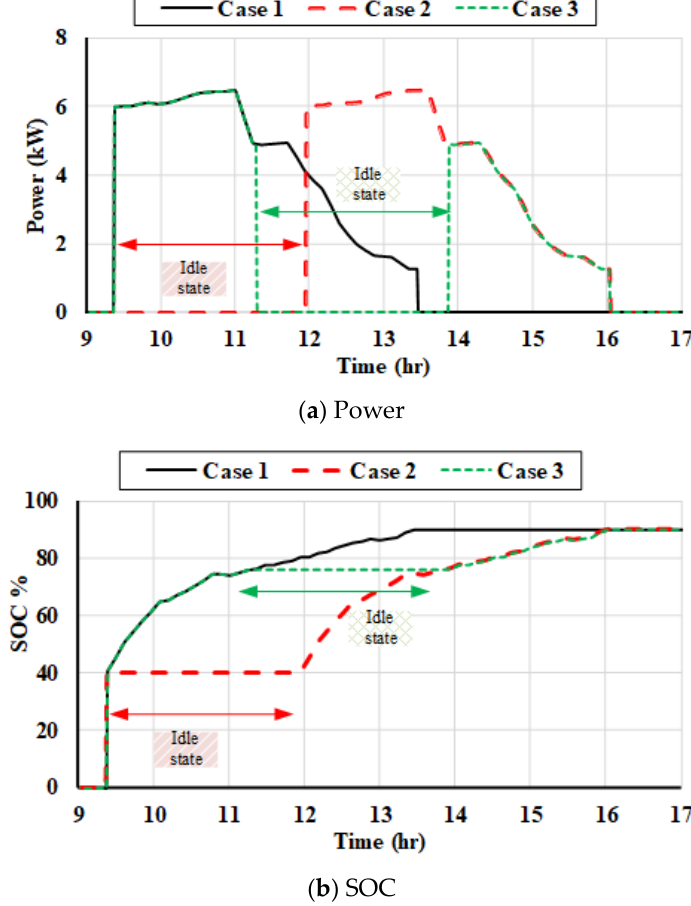
Figure 17. EV# i charging behavior at different case studies.